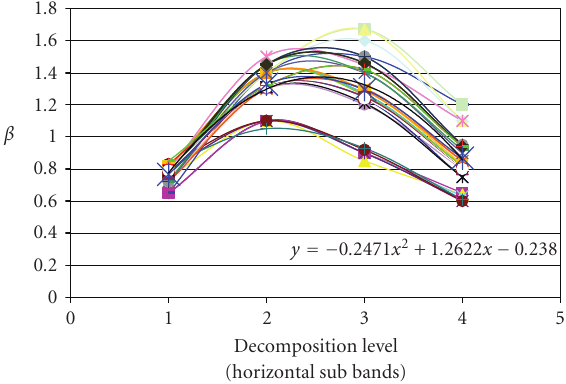
Figure 3: β variation in horizontal subbands of a set of scinti- graphic images (in black the polynomial y that approximates the average variation). Table 1: Statistics on the value of β (for 100 scintigraphic images). β ≤ 0 . 5 0 . 5 ≤ β ≺